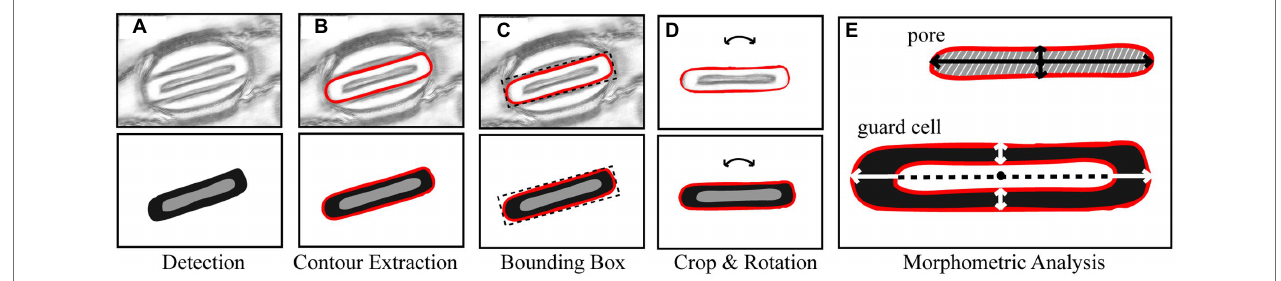
FIGURE 3 | Overview of the stages of stomata morphometry extraction. (A) each stoma is detected using the CNN model described in Figure 1 ; (B) the contour is extracted; (C) a bounding box is applied to the contour; (D) the bounding box is rotated using the primary eigen vector and the stoma contained within the contour is cropped; and (E) morphometric measurements of the guard cell and pore are automatically extracted including guard cell and pore length and widths plus peristomatal groove